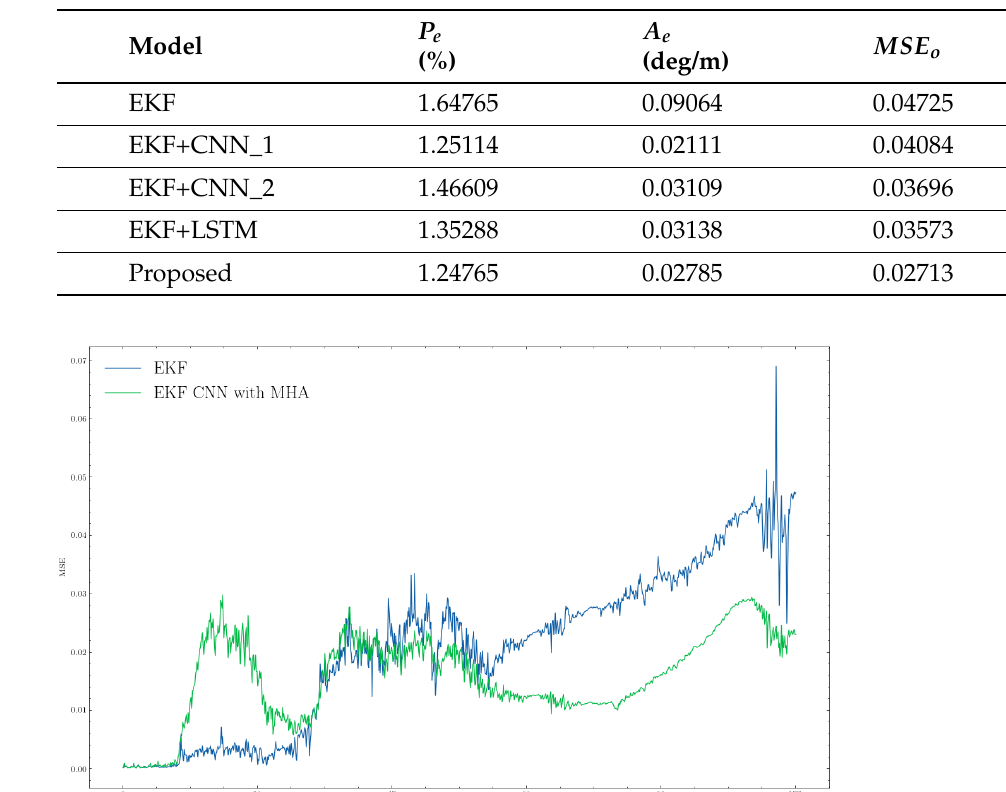
Table 2. Results for the four trajectory paths followed by evaluation metrics. Failure length: moving track length of robot during SLAM failure period; P e : position error; A e : rotation error; MSE o : overall mean squared error. CNN_1 is the proposed model architecture without the multi-head attention layer. CNN_2 is the same as CNN_1 but removes the last convolution layer. LSTM is implemented with a number of 2 layers and a hidden size of 256.